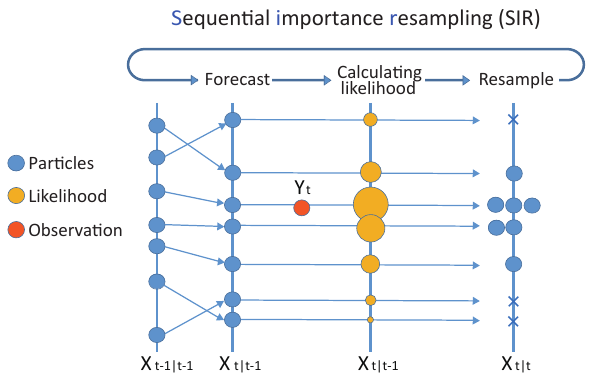
Figure 1. Schematic showing the SIR particle filter method. The size of the circles corresponds to the assigned